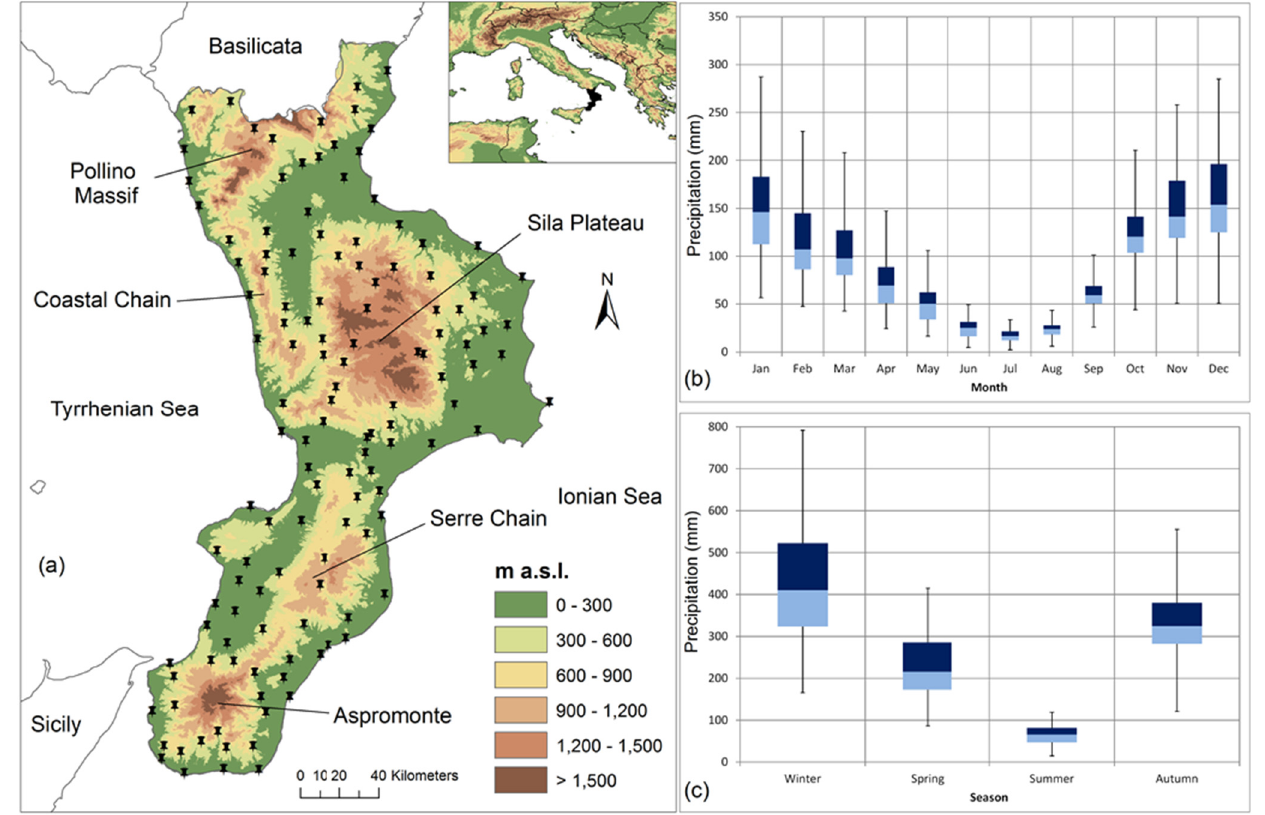
Figure 1. ( a ) Location of the selected stations on a Digital Elevation Model (DEM) of Calabria; ( b ) regional monthly precipitation distribution; and ( c ) regional seasonal precipitation